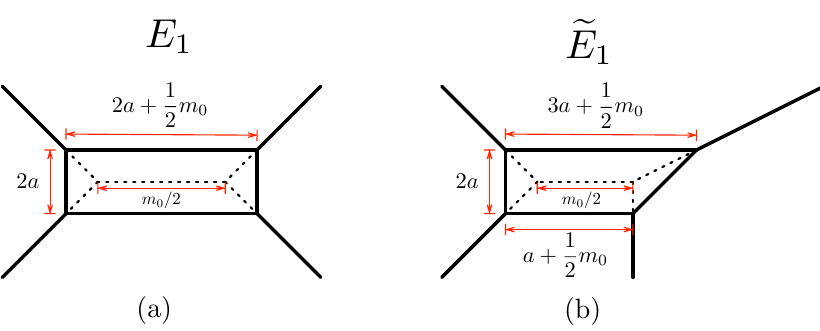
Figure 1 . (a) A 5-brane web for pure SU(2) pure SU(2) (cid:25) gauge theory (or